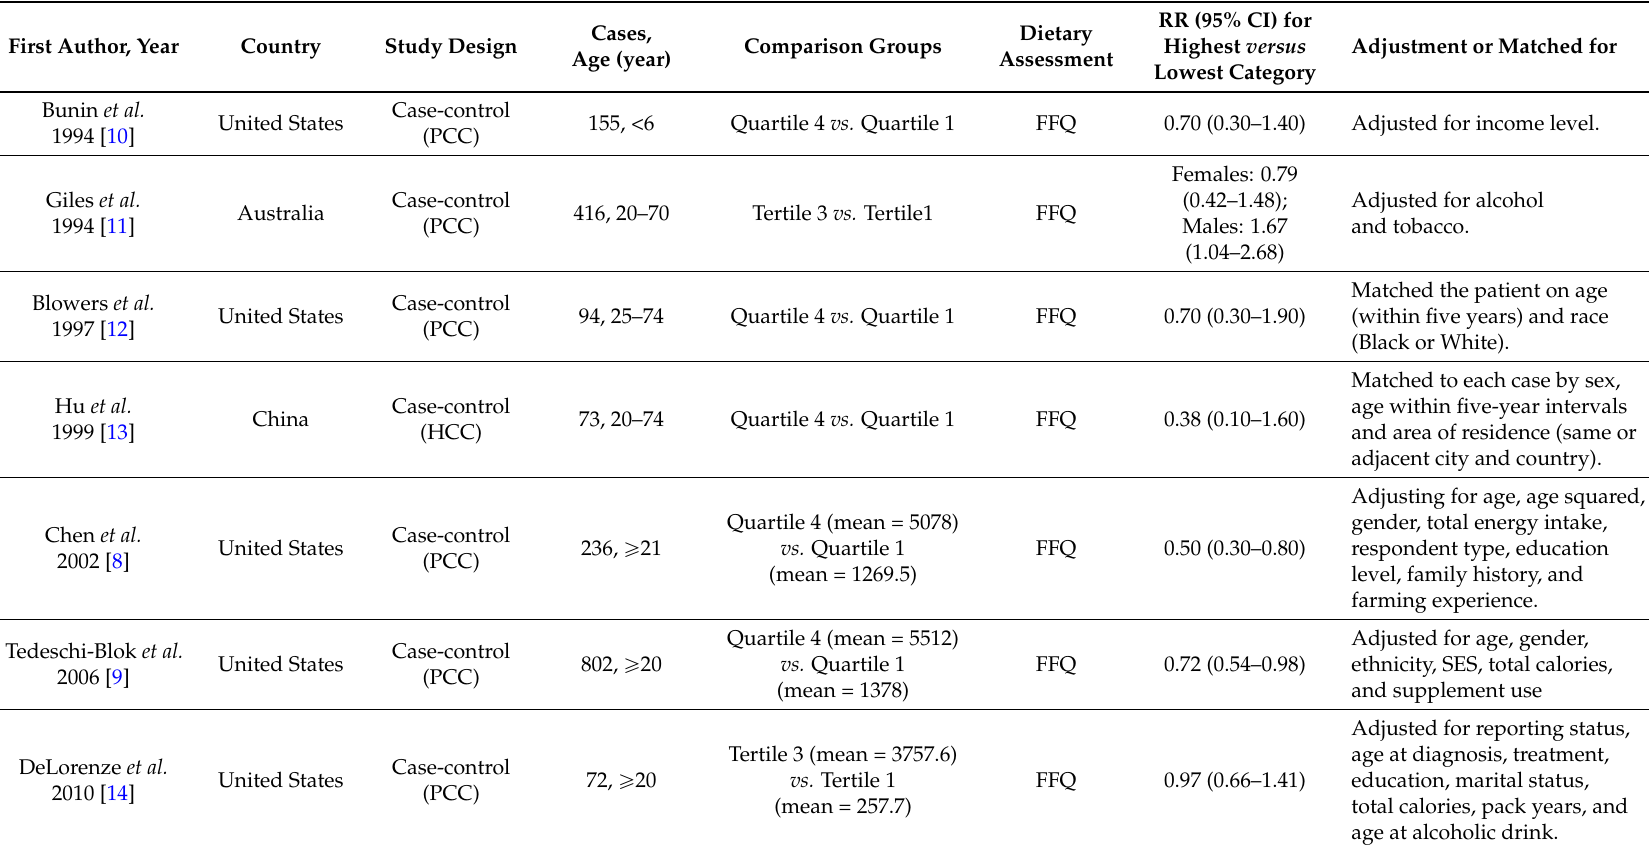
Table 1. Characteristics of studies on vitamin A intake and glioma